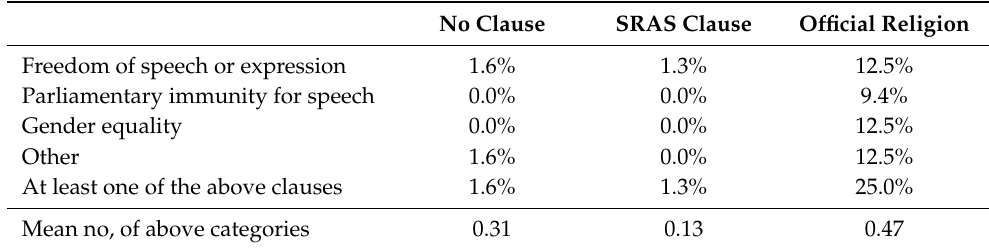
Table 5. Rights and freedoms qualified by religion in